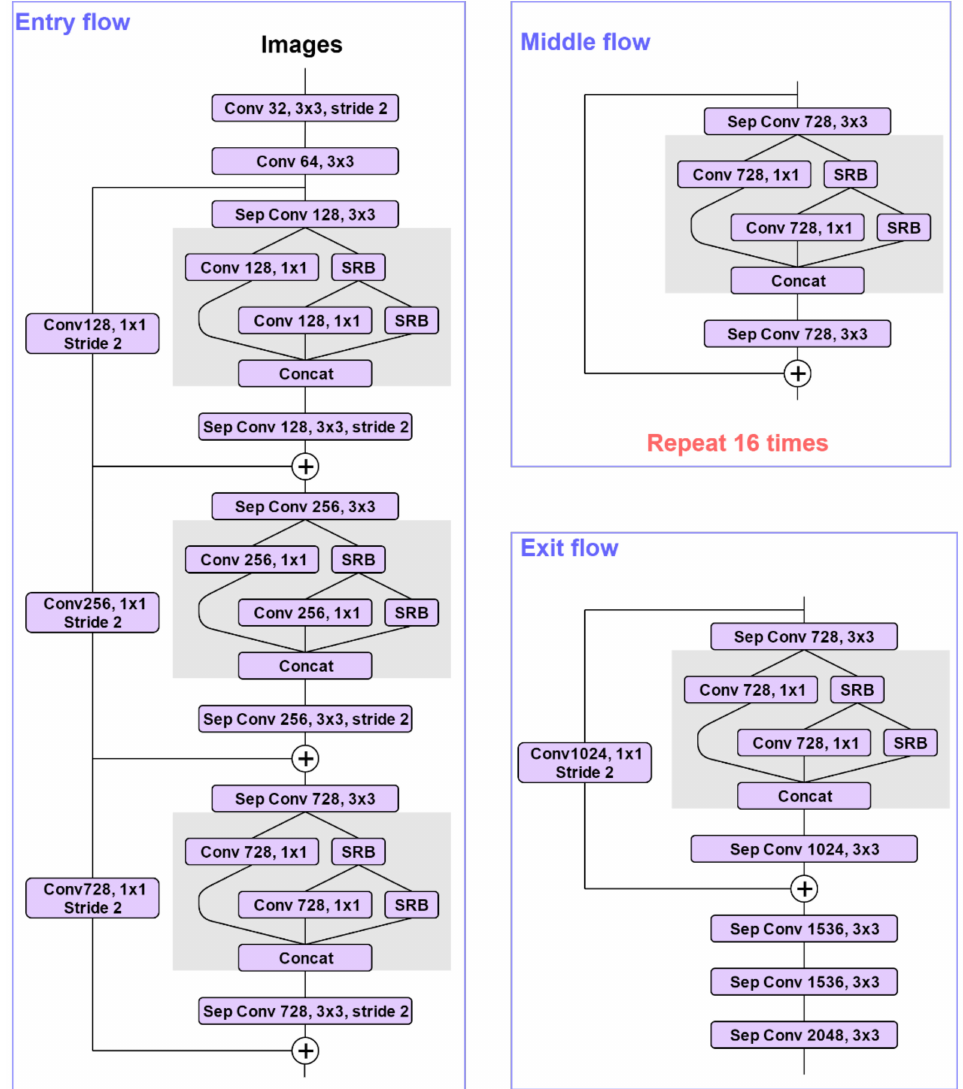
Figure 4. The Xception model is modified as follows: The second depth-wise separable convolution is replaced by the FDB in the residual block of input flow, middle flow, and exit